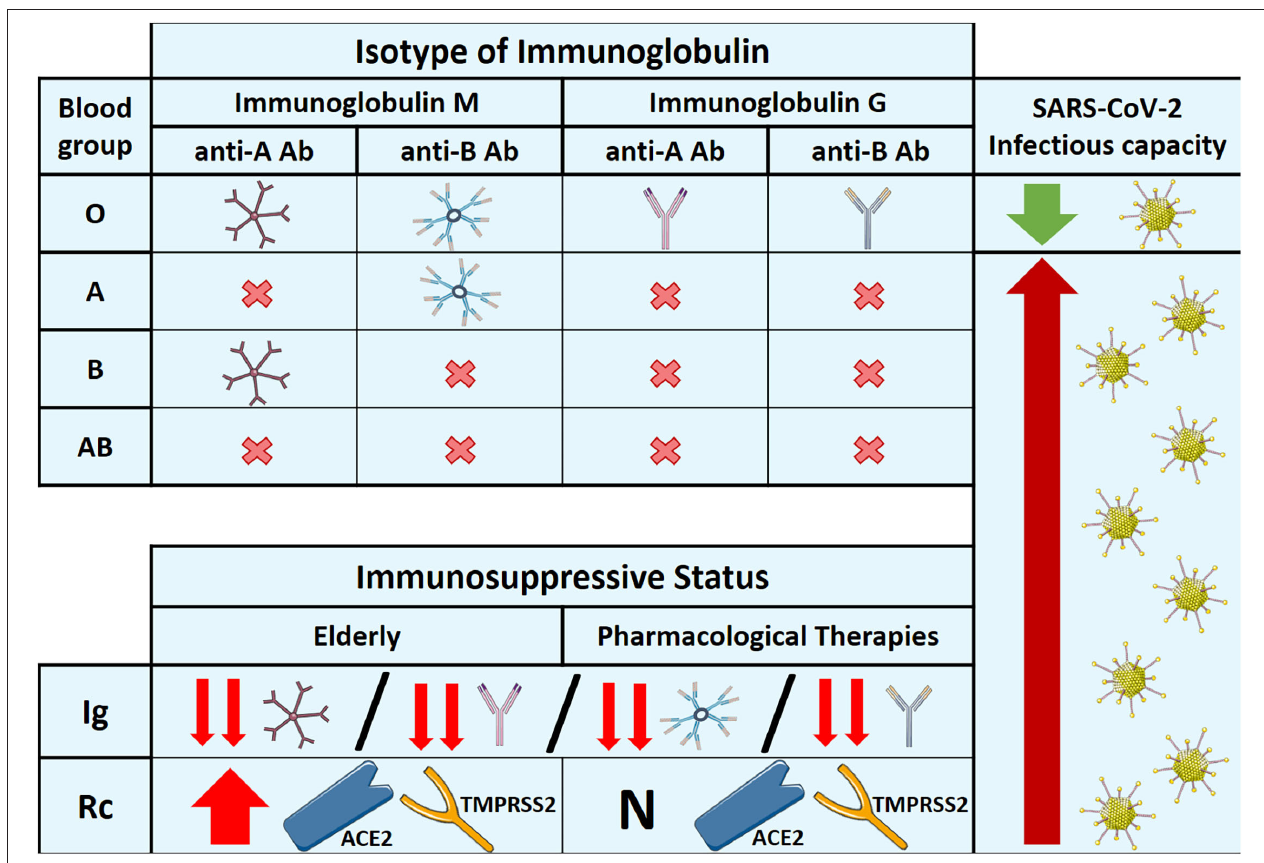
FIGURE 2 | Specific isotype of immunoglobulin in each ABO blood group, expression of natural antibodies and receptors in immunosuppressive situations, and their relationship with the infectious capacity of SARS-CoV-2. Ab: antibody. Rc: receptor. Ig: immunoglobulin. ACE2: angiotensin-converting enzyme 2. TMPRSS2: transmembrane protease serine subfamily member. N; normal